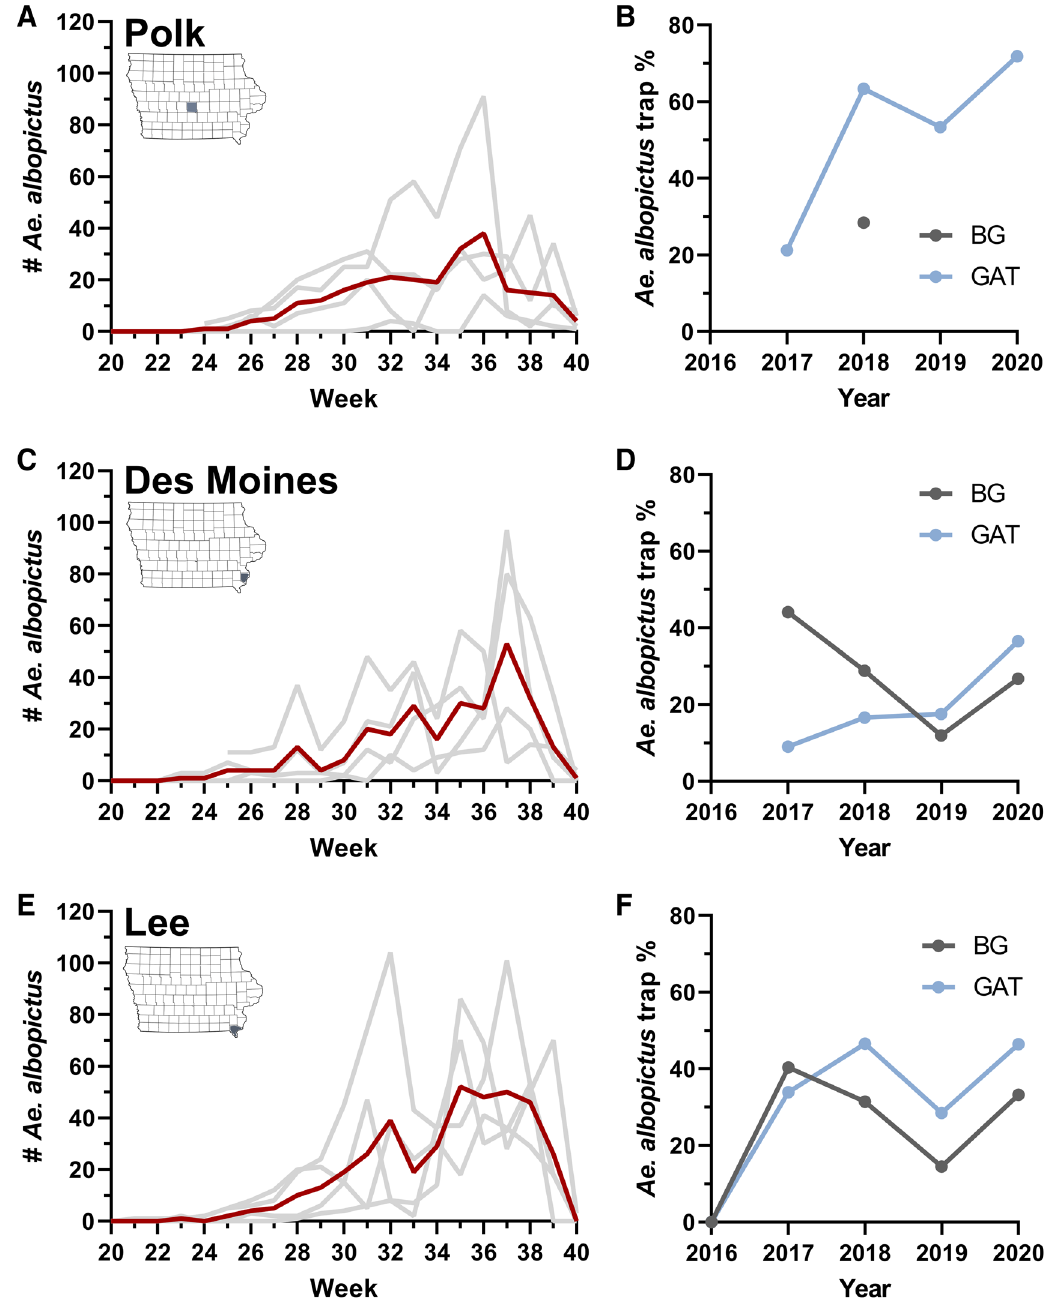
Figure 2. Abundance of Ae. albopictus in each positive Iowa county. The temporal abundance and percentage of Ae. albopictus in overall trap yields is displayed for Polk ( A, B ), Des Moines ( C, D ) and Lee County ( E, F ). Temporal abundance for each county ( A, C, E ) is displayed by epidemiological week, with the average abundance (2017–2020) displayed in red, while individual years are denoted by light gray lines. The percentage of Ae. albopictus collected of the total trap yields ( B, D, F ) are displayed for BG Sentinel (BG) and Gravid Aedes traps (GAT) for each